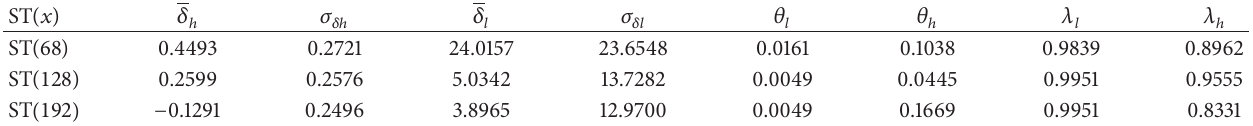
Table 7: Direct comparison statistics for different ST (𝑥) range values.